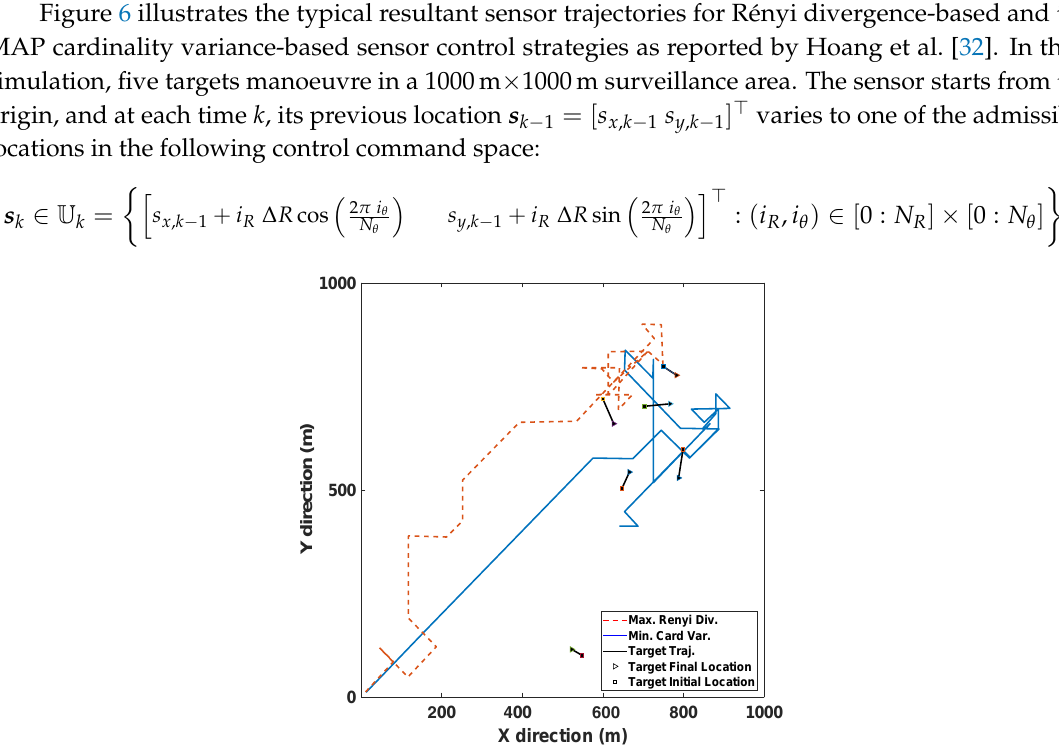
Figure 6. Sensor trajectories of the MAP cardinality variance-based and Rényi divergence-based sensor control